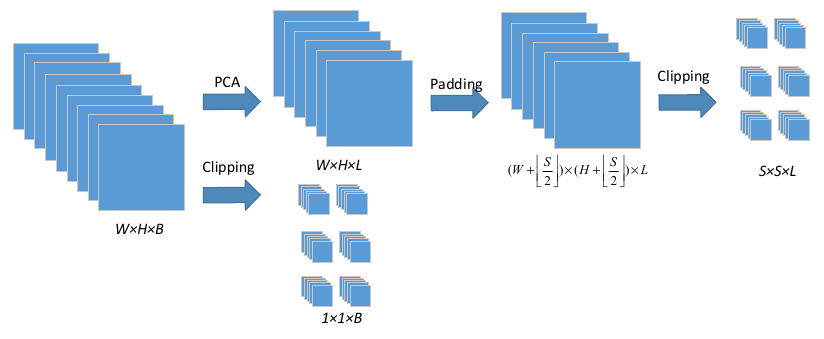
Figure 7. Data preprocessing.